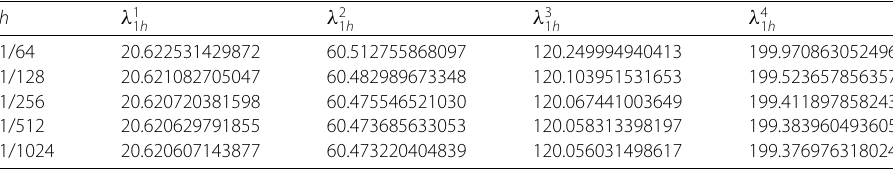
Table 5 a = 0, the four eigenvalues with l = 1 and h h